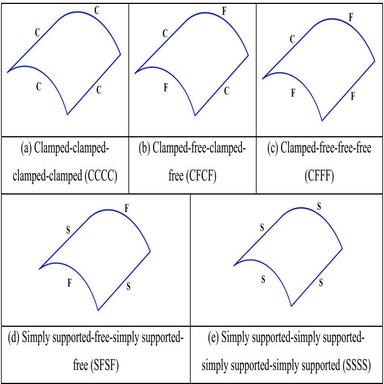
Various end conditions considered for the analysis.